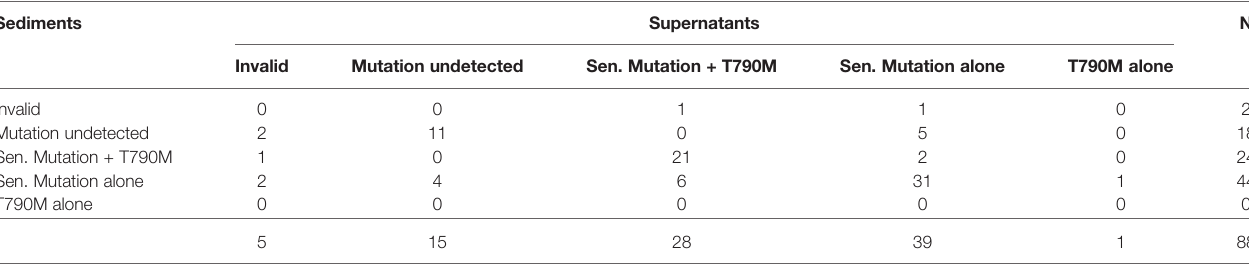
TABLE 5 | EGFR T790M mutation status by sediments and supernatants.